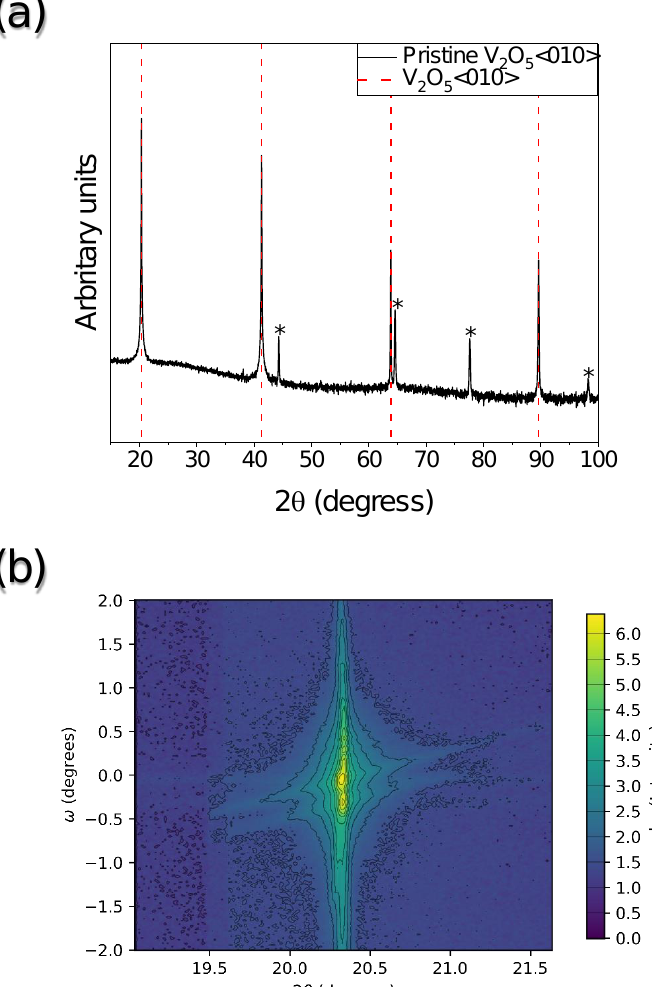
Figure 1. XRD measurements of a pristine, cleaved V 2 O 5 (010) single crystal. ( a ) The θ –2 θ measure- ment reveals sharp V 2 O 5 <010> peaks. The asterisk is due to the sample stage. ( b ) The reciprocal space map of the V 2 O 5 (010) peak is characteristic of a single